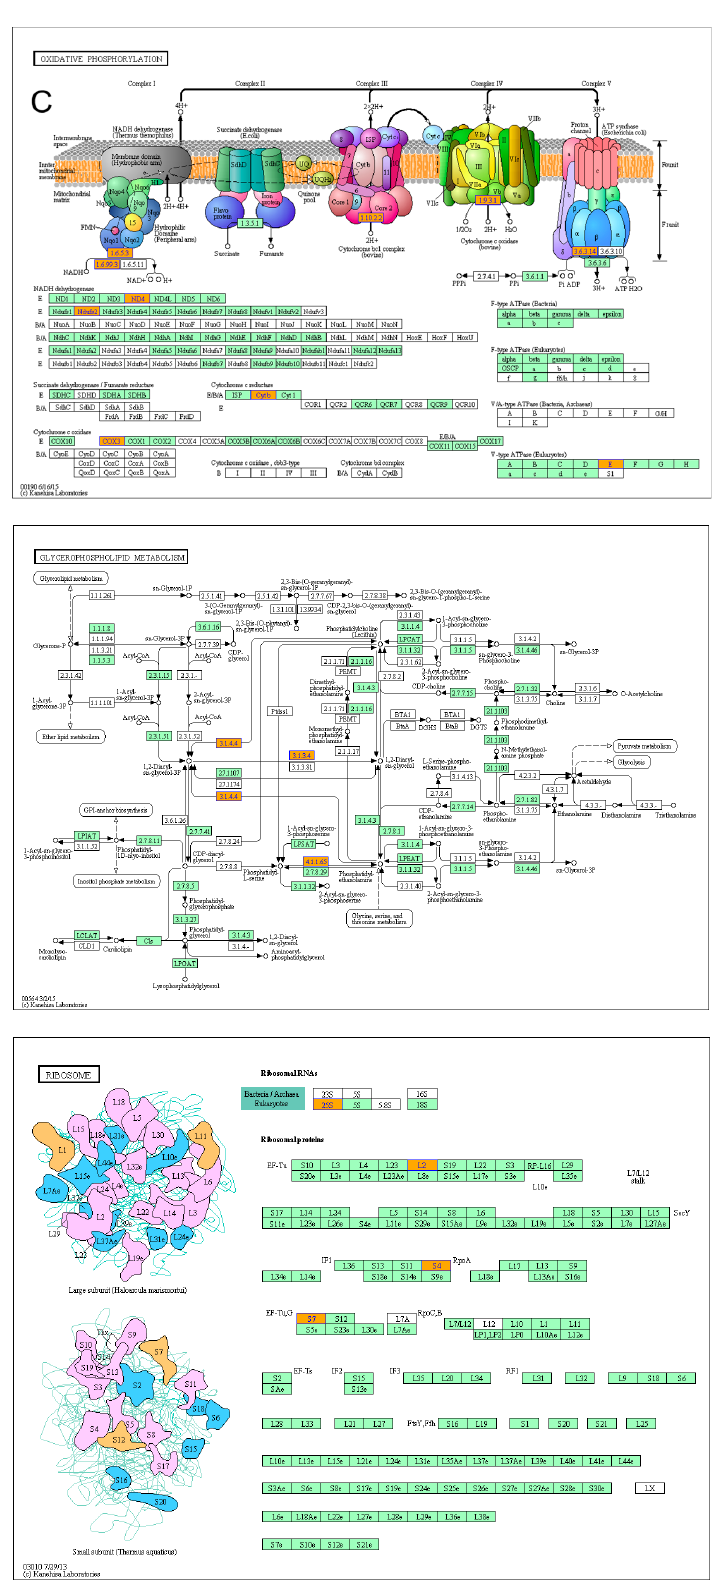
Figure 4. CHIP − SEQ analysis in 35S::HAOFP1 transgenic Arabidopsis plants. ( A ) The CHIP Peaks exploration from the comparison of 35S::HAOFP1 and Arabidopsis reference genome. The number of pass-filtering reads and uniquely aligned reads are listed in the table (Top). Among them, Promoters Peaks were defined as 2000 bp upstream and downstream from the TSS (Transcriptional Start